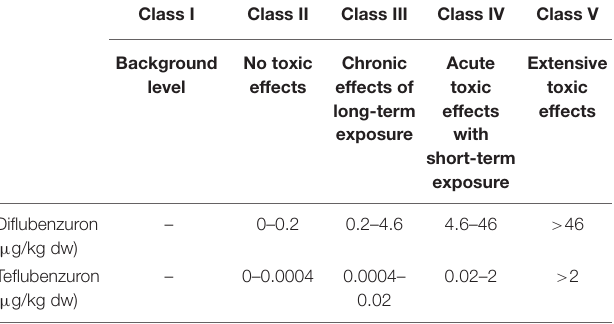
TABLE 3 | EQS classification system for diflubenzuron and teflubenzuron in Norwegian